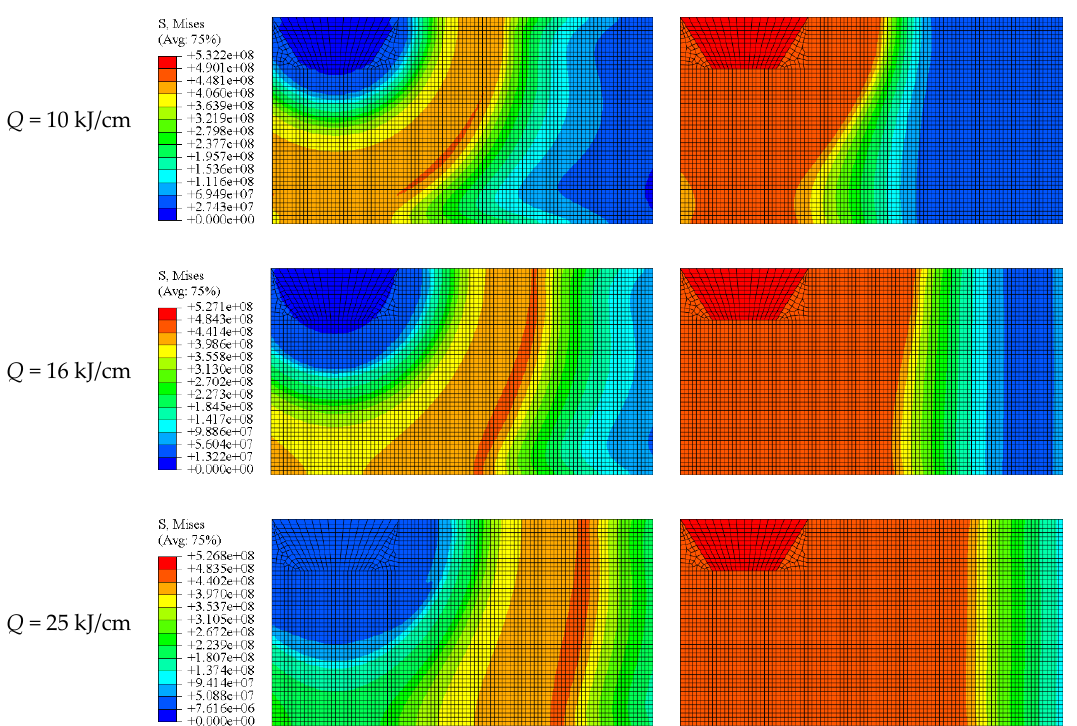
Figure 18. Stress contours at the end instant of repair welding and the end instant of cooling for different linear energy.